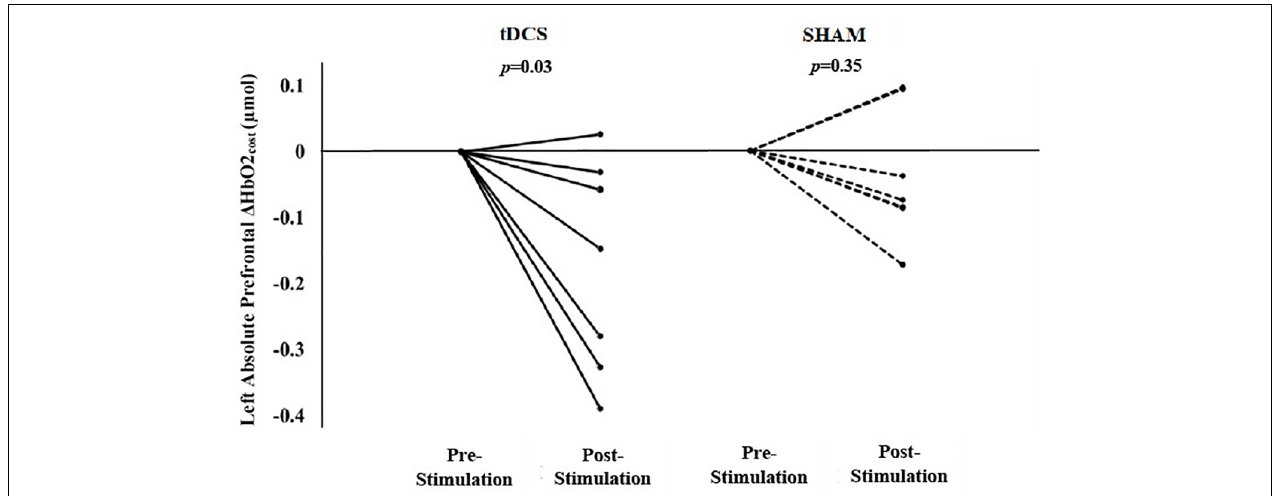
FIGURE 2 | Participant-level data by group for the after-effects of a single session of tDCS or sham stimulation on left prefrontal (cid:49) HbO2 cost (i.e., the absolute difference between dual task and usual walking). tDCS resulted in significant group changes in left (cid:49) HbO2 cost (i.e., smaller left prefrontal HbO2 response from usual to dual task walking). Six of seven participants exhibited a reduction in left (cid:49) HbO2 cost . The sham stimulation resulted in insignificant group changes in left (cid:49) HbO2 cost . (Baseline data is normalized to zero where the post-intervention data reflects the absolute change in the left prefrontal (cid:49) HbO2 cost from pre- to